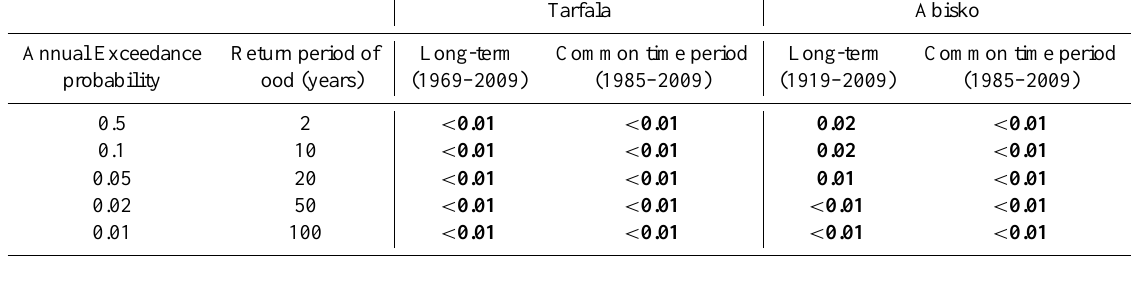
Table 5. P -values of non-stationarity test on selected percentiles (50th, 90th, 95th, 98th, and 99th) of the annual maximum discharge data of the Tarfala and Abisko catchments. The percentiles were estimated by performing a moving window analysis with a 10-yr window. Non- stationarity was estimated at a significance level of 5% by performing a trend analysis on the quantiles using a generalized least squares regression model. 2-sided p -values smaller than 0.05 and highlighted in bold indicate that the selected quantiles exhibited non-stationarity.